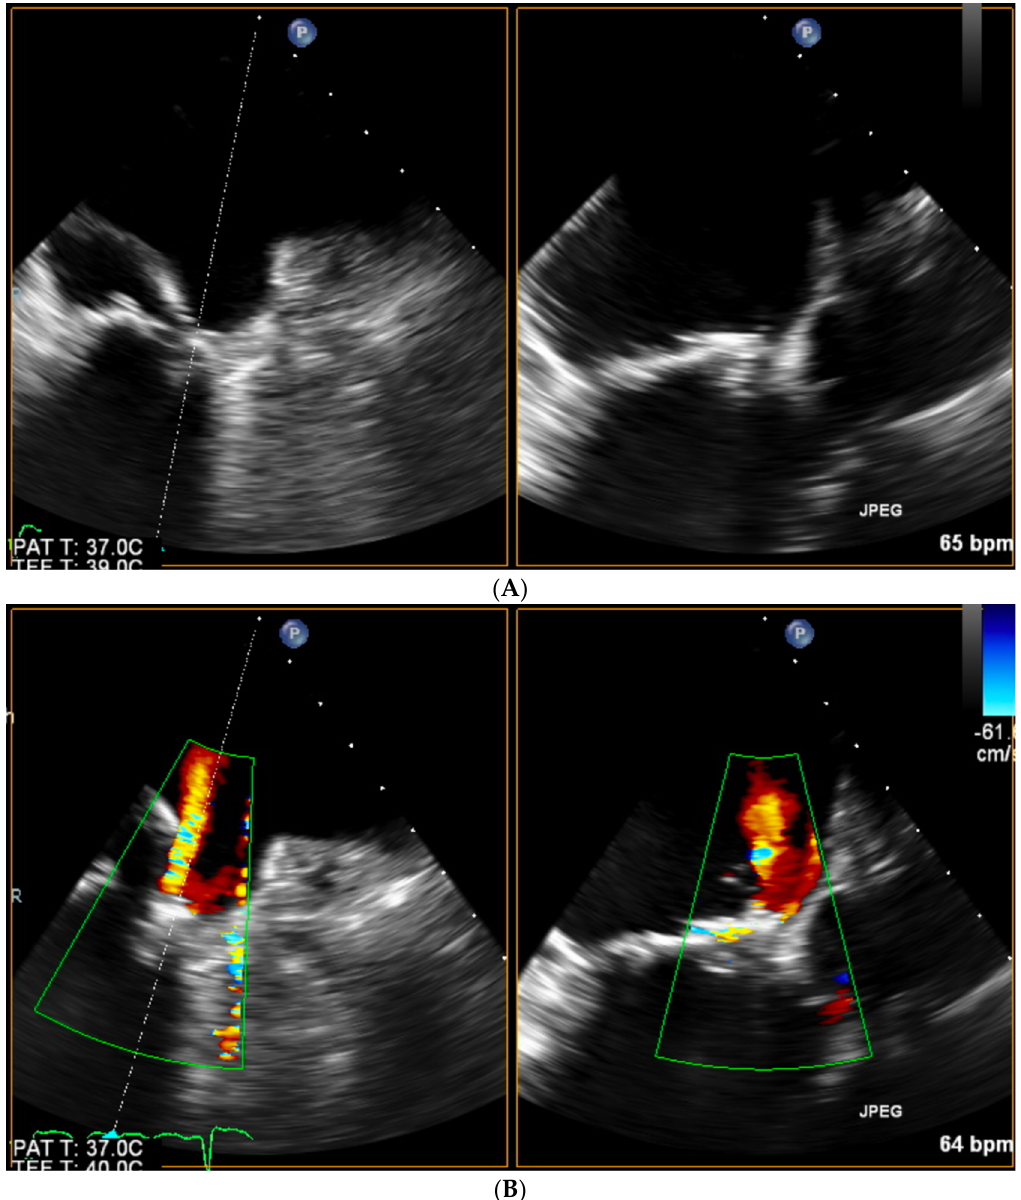
Figure 5. ( A ) Biplanar imaging of the tip of the catheter at the sewing ring of prosthetic valve. ( B ) Biplanar color doppler marking of the PVL’s narrow orifice enabling precise catheter maneuver- ing.